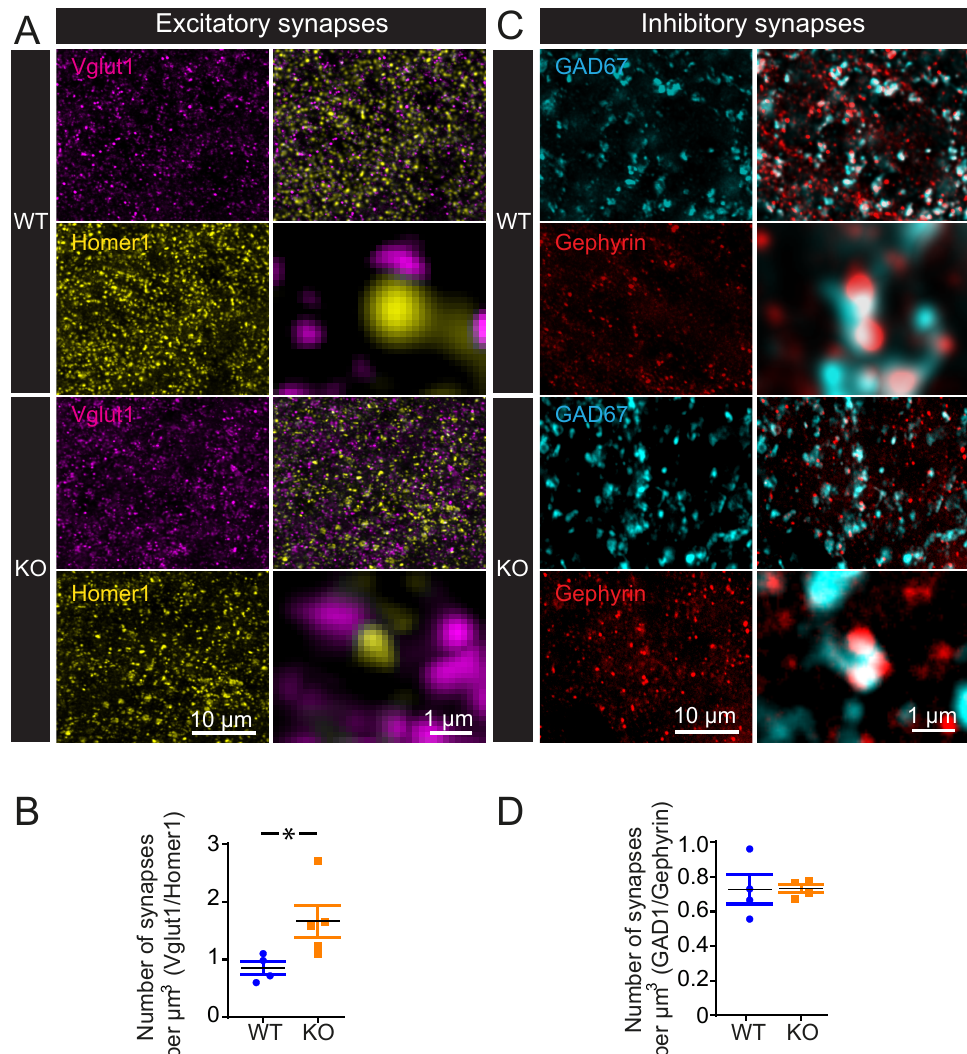
Figure 3. OPHN1 deficiency induces a selective increase in the number of excitatory synapses in adult mice. ( A , C ) Representative images of excitatory synapses, labeled with Vglut1 (magenta) and Homer1 (yellow), and inhibitory synapses, labeled with Gad677 (cyan) and Gephyrin (red). ( B ) Quantification of the numbers of excitatory synapses (WT: n = 17,674 synapses from n = 4 mice, KO: n = 29,377 synapses from n = 5 mice) (unpaired t -test, p = 0.0469; DF = 7). ( D ) Quantification of the number of inhibitory synapses (WT: n = 5125 synapses from n = 4 mice, KO: n = 5155 synapses from n = 4 mice) (unpaired t -test, p = 0.9633; DF = 6). Asterisks indicate statistical significance (* p <